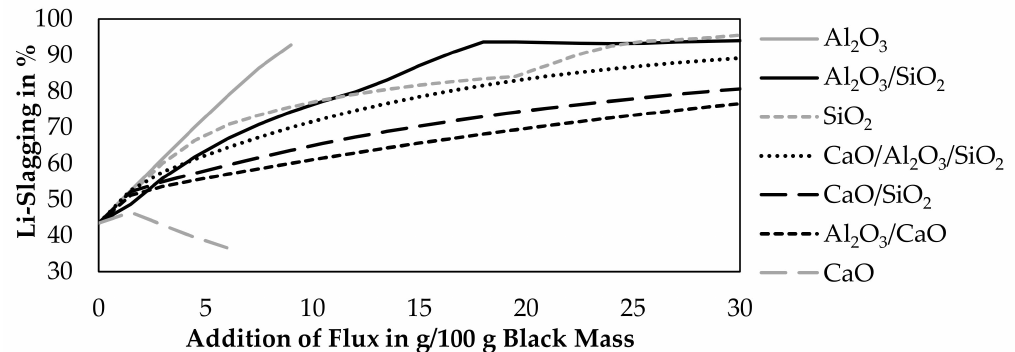
Figure 3. Influence of fluxing on the Li-slagging at 1600 ◦ C with an addition of 65 g CuO per 100 g black